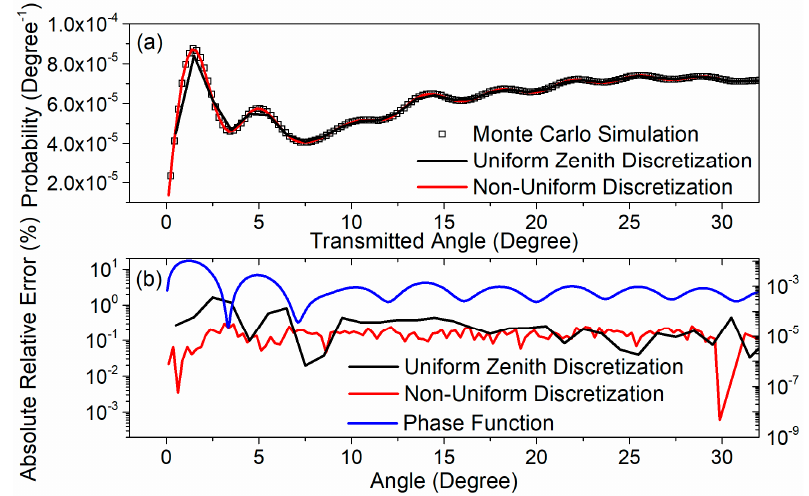
Figure 9. Solutions from Markov chain approximations compared to Monte Carlo simulations with zenith angle discretization scheme 2. Phase function 3 was selected and OD = 5.0. Panel ( a ). Transmitted angular distribution, Panel ( b ). Absolute relative error.